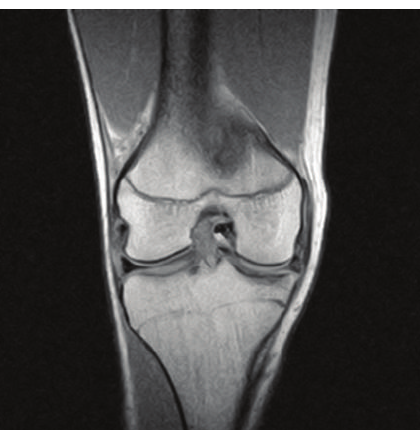
Figure 3: Coronal MRI of the right knee revealing intra-articular and bucket-handle medial meniscus tear with the displaced fragment located in the intercondylar notch.